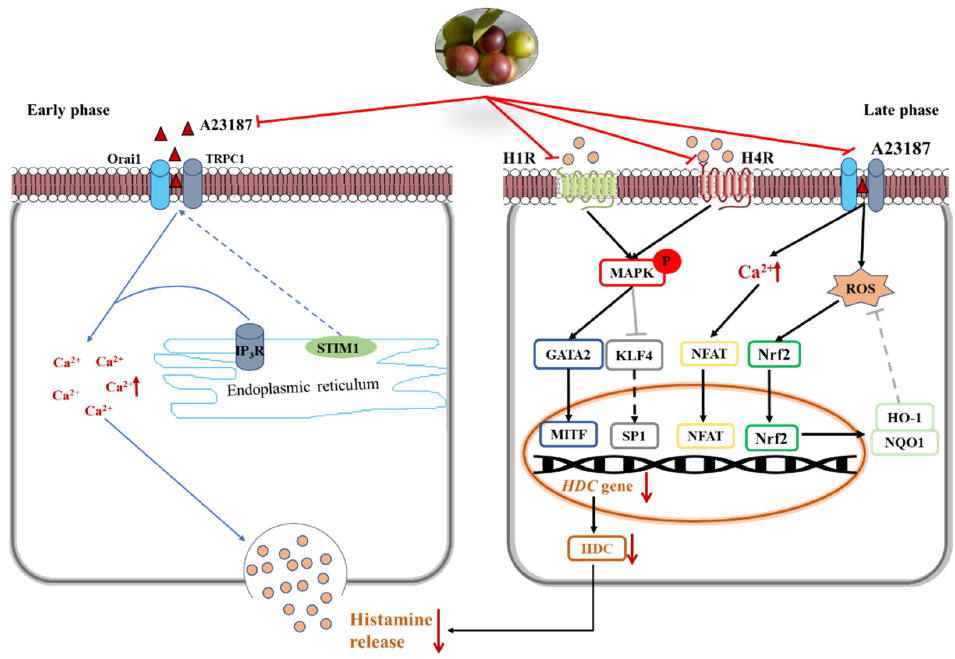
Figure 11. Inhibitory effect of camu-camu fruit extract on mast cells via regulation of H1R and